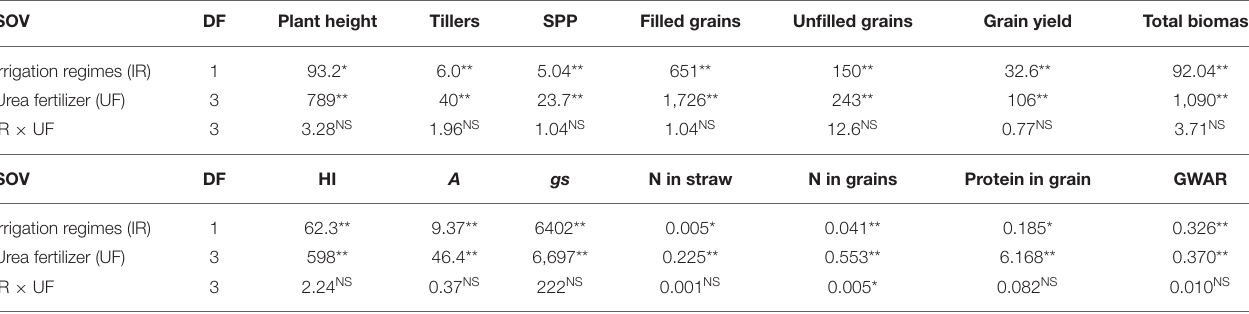
TABLE 1 | Mean sum of squares of plant height, tillers, spikelets per panicle, filled grains, unfilled grains, grain yield, total biomass, harvest index, photosynthesis rate, stomatal conductance, nitrogen in straw and grains, protein in grains, and grain water absorption ratio of rice plants grown in aerobic and anaerobic regimes with applications of conventional urea, neem-coated urea, and zinc-coated urea. SOV DF Plant height Tillers Filled grains Irrigation regimes (IR)